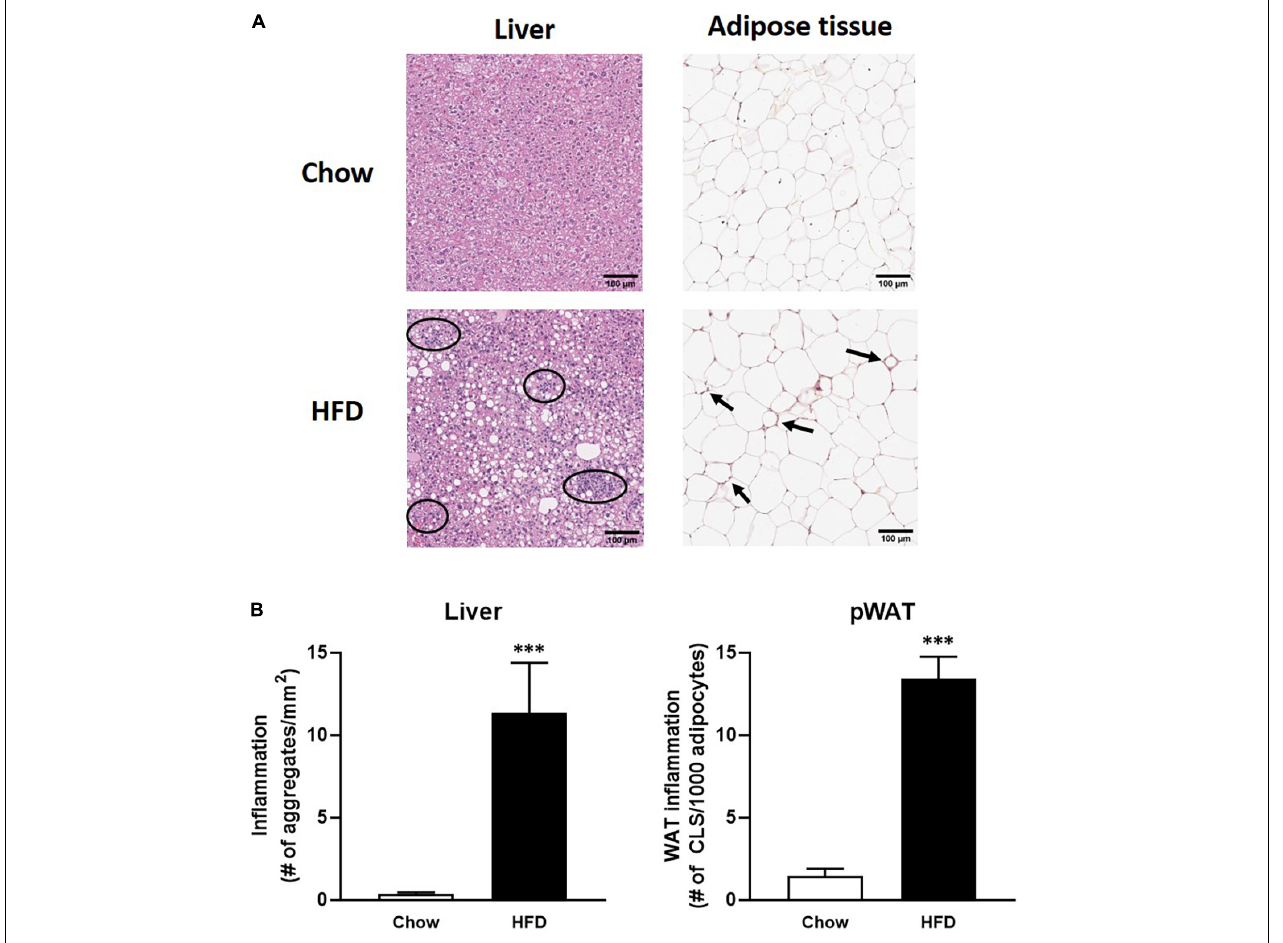
FIGURE 2 | (A) Panels of immuno-histochemical staining of inflammatory aggregates in liver and adipose tissue; (B) quantification of inflammatory aggregates in HFD-fed mice (black bars) in liver (left) and adipose tissue (right) as compared to chow fed mice (open bars). ∗∗∗ indicates significance with P -values <